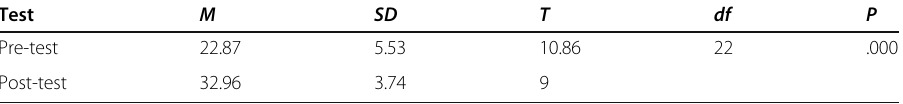
Table 1 Mean Score, Standard Deviation, and Paired Sample t-test Results of the Pre- &